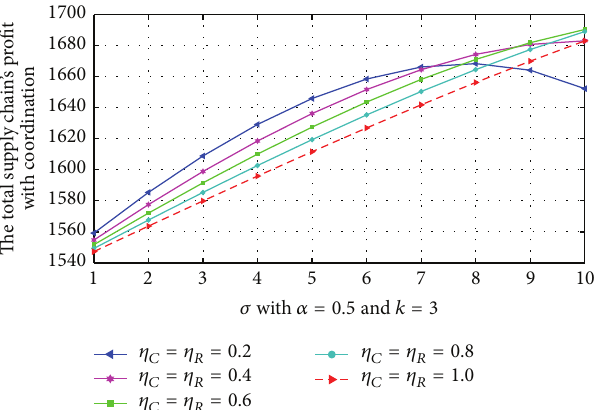
Figure 2: Impact of changes of 𝜎 on the total supply chain’s profit with coordination in different 𝜂 𝑅 .